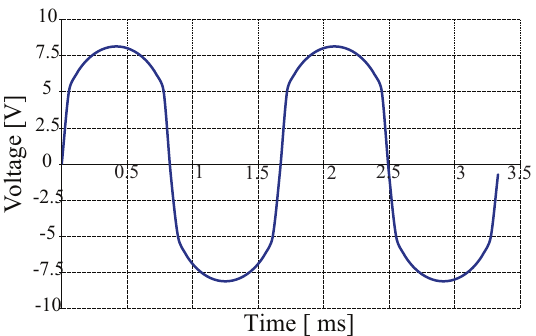
Figure 9: Evolution in time of the terminal